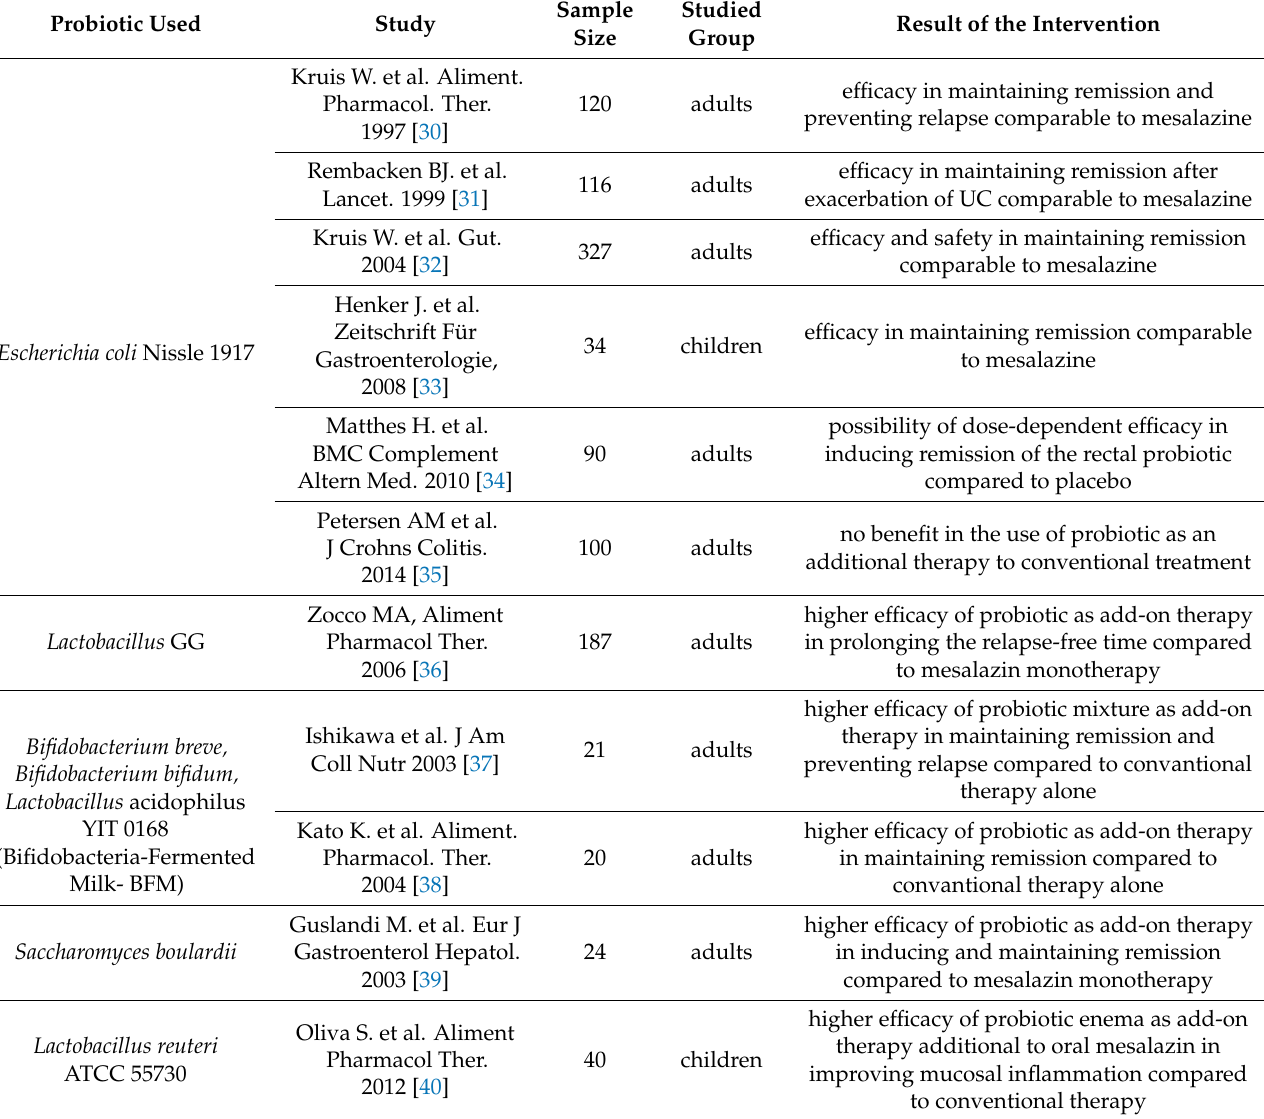
Table 1. Results of clinical studies of using probiotics in ulcerative colitis patients. Probiotic Used Study